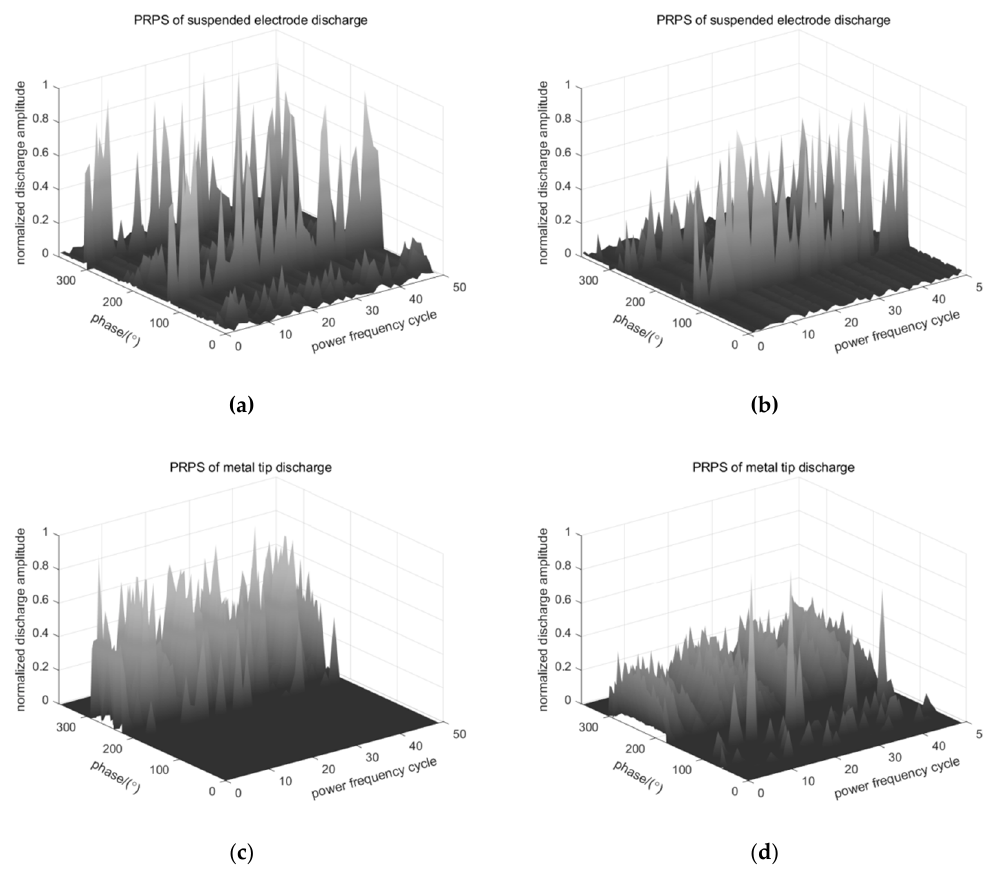
Figure 5. ( a ) 3D graphs of PRPS under suspended electrode defect at 22.6kV; ( b ) 3D graphs of PRPS under suspended electrode defect at 25.8kV; ( c ) 3D graphs of PRPS under metal tip defect at 6.5kV; ( d ) 3D graphs of PRPS under metal tip defect at